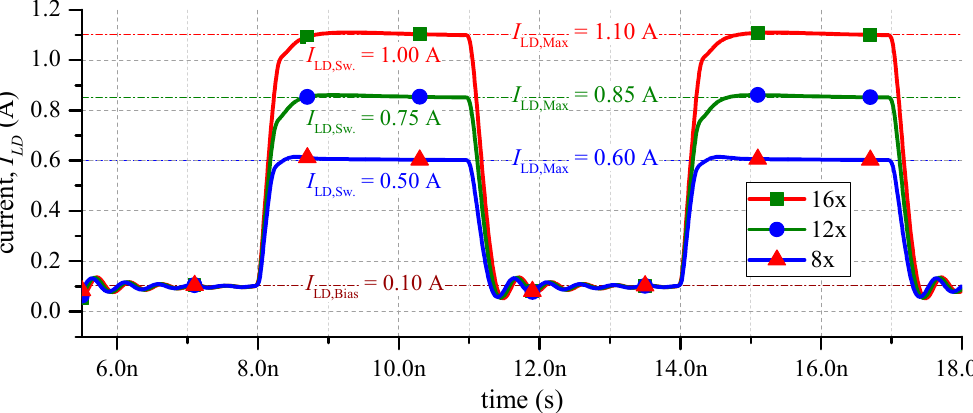
Figure 9. The simulation results of the proposed driver while operating for multiple target current levels. Table 1. Comparison of the existing techniques with the proposed negative voltage boosting. Parameter